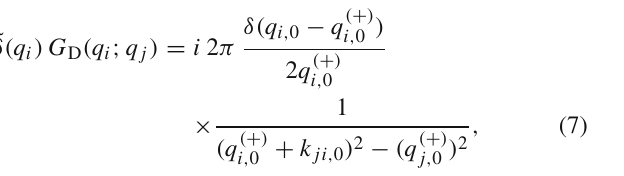
with singularities appearing at the intersection of each for- ward on-shell hyperboloid with the forward of backward on- shell hyperboloid of the other propagators. A crucial point of this discussion is the observation that dual propagators